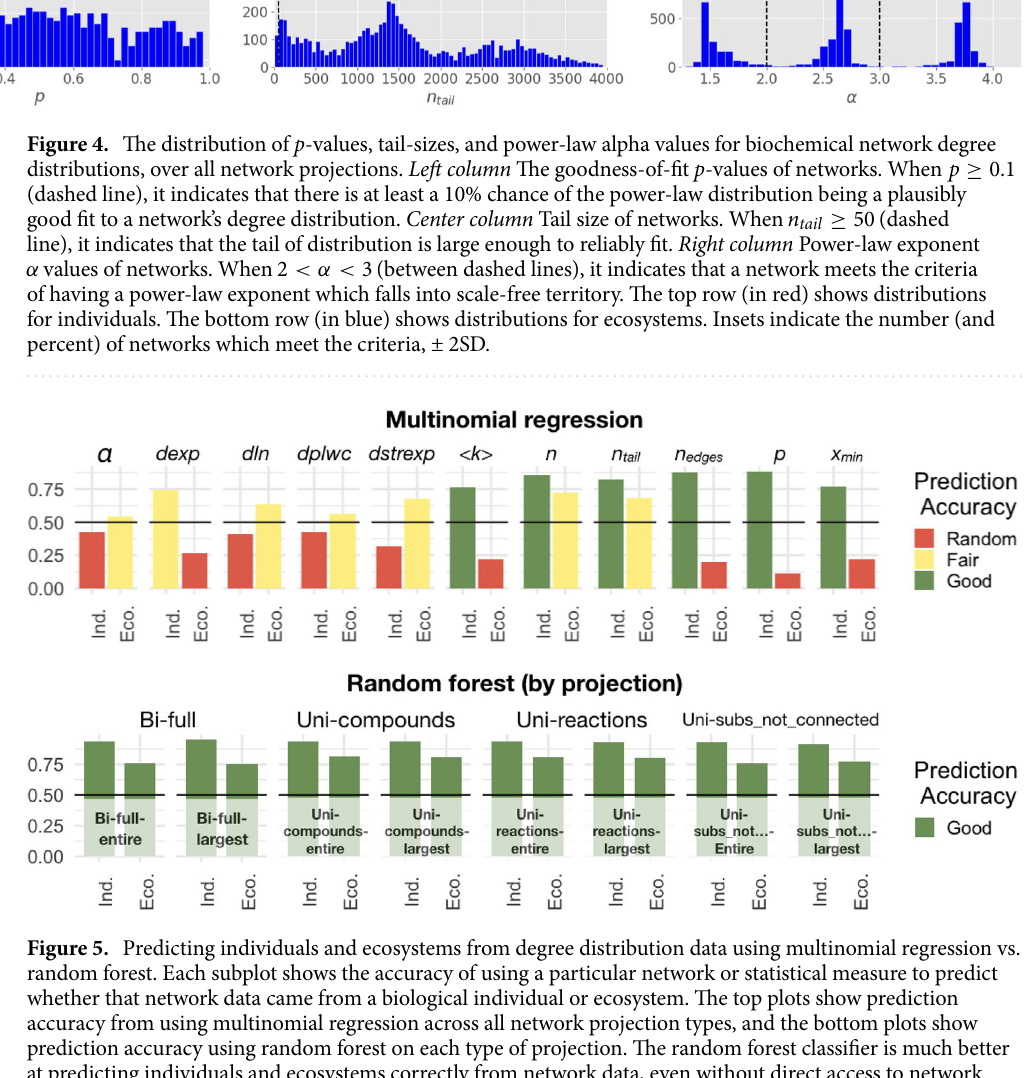
Figure 5. Predicting individuals and ecosystems from degree distribution data using multinomial regression vs. random forest. Each subplot shows the accuracy of using a particular network or statistical measure to predict whether that network data came from a biological individual or ecosystem. The top plots show prediction accuracy from using multinomial regression across all network projection types, and the bottom plots show prediction accuracy using random forest on each type of projection. The random forest classifier is much better at predicting individuals and ecosystems correctly from network data, even without direct access to network size. All random forest predictions have an accuracy of at least 75% across all projection types. Subplots measures are: power-law alpha value; log-likelihood result from power-law vs. exponential; log-likelihood result from power-law vs. log-normal; log-likelihood result from power-law vs. power-law with exponential cutoff; log-likelihood result from power-law vs. stretched exponential; the network mean degree; network node size; degree distribution tail size; network edge size; the p -value of the goodness-of-fit test for the power-law model; cutoff degree value for network tail. These are the only predictors used in the random forest classifier. Prediction 50% , Fair if > 50% , and Good if 75% accuracy is random if ≤ ≥